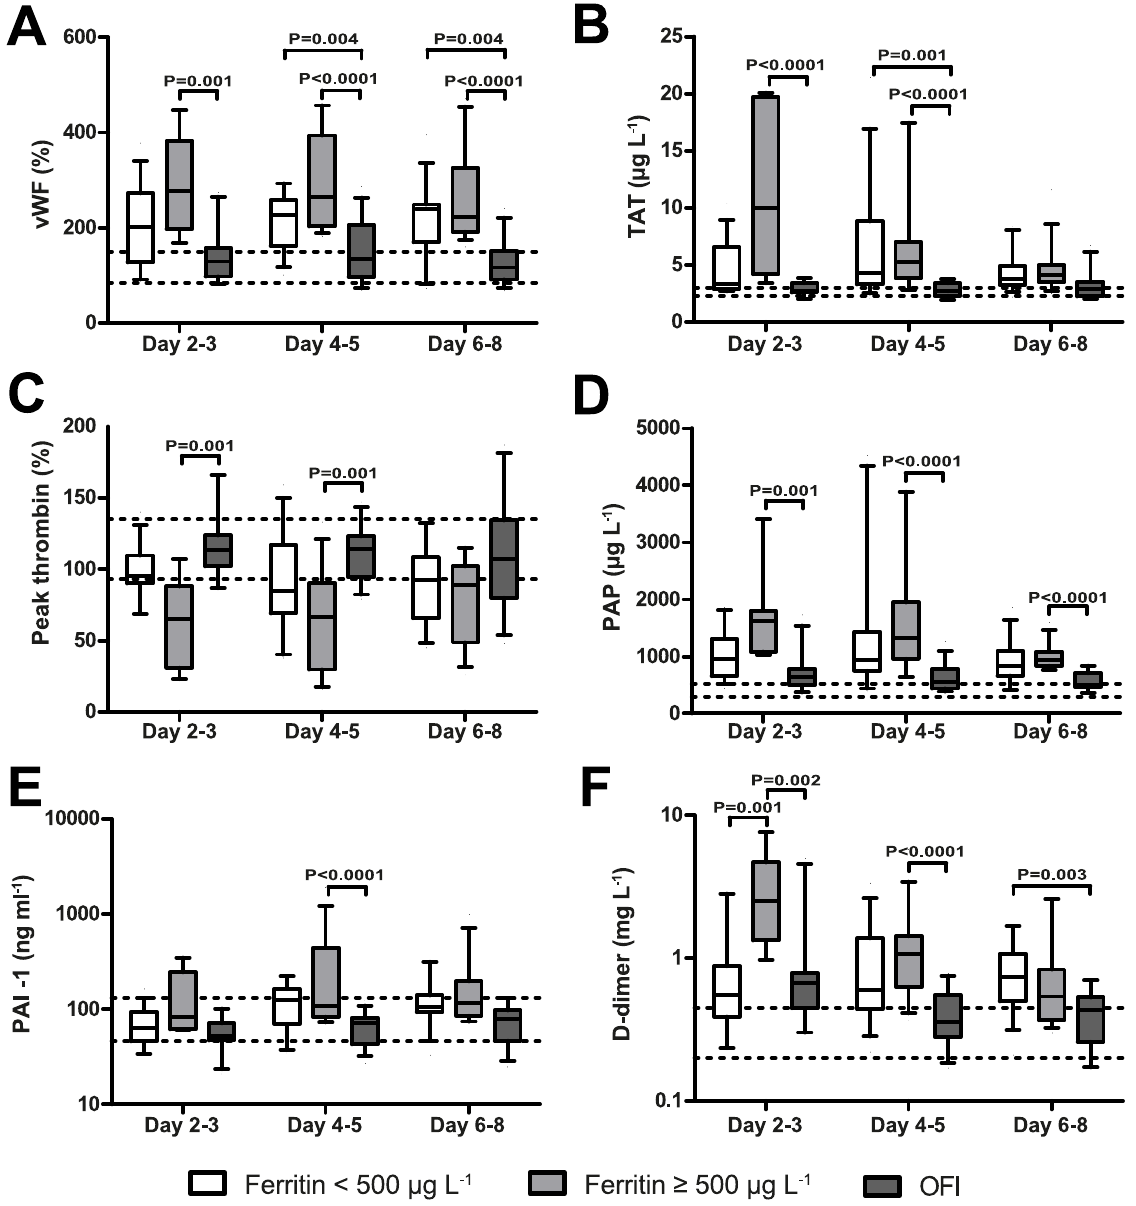
Figure 4. Hyperferritinaemia is associated with markers of coagulation and fibrinolysis. Levels of vWF were significantly increased in patients with hyperferritinaemia compared to OFI at each time point and significantly increased in patients without hyperferritinaemia compared to OFI at day 4–5 and 6–8 (A) in the cohort from Aruba. Levels of TAT (B) were significantly increased and levels of peak thrombin (C) significantly decreased in patients with hyperferritinaemia at day 2–3 and 4–5. Levels of PAP were significantly increased in patients with hyperferritinaemia compared to OFI (D). Levels of PAI-1 were significantly increased in patients in patients with hyperferritinaemia compared to OFI at day 4–5 (E). Levels of D-dimer were significantly increased in patients with hyperferritinaemia compared to OFI at day 2–3 and 4–5 and in patients with hyperferritinaemia compared to patients without hyperferritinaemia at day 2–3 (F). Missing values vWF, PAI-1: Day 2–3: OFI (N=1). Day 4–5: HF (N=1); TAT, PAP, D-dimer: No missing values; Peak thrombin: Day 2–3: No (N=1), OFI (N=1). Day 4–5: No (N=1), HF (N=4), OFI (N=2). Day 6–8: No (N=2), HF (N=1), OFI (N=2). Area between two dotted horizontal lines: interquartile range from the autologous control group. Boxplots indicate the interquartile range, the horizontal line inside the box indicates the median. The whiskers reach from the 10 th till the 90 th percentile. P-value # 0.006